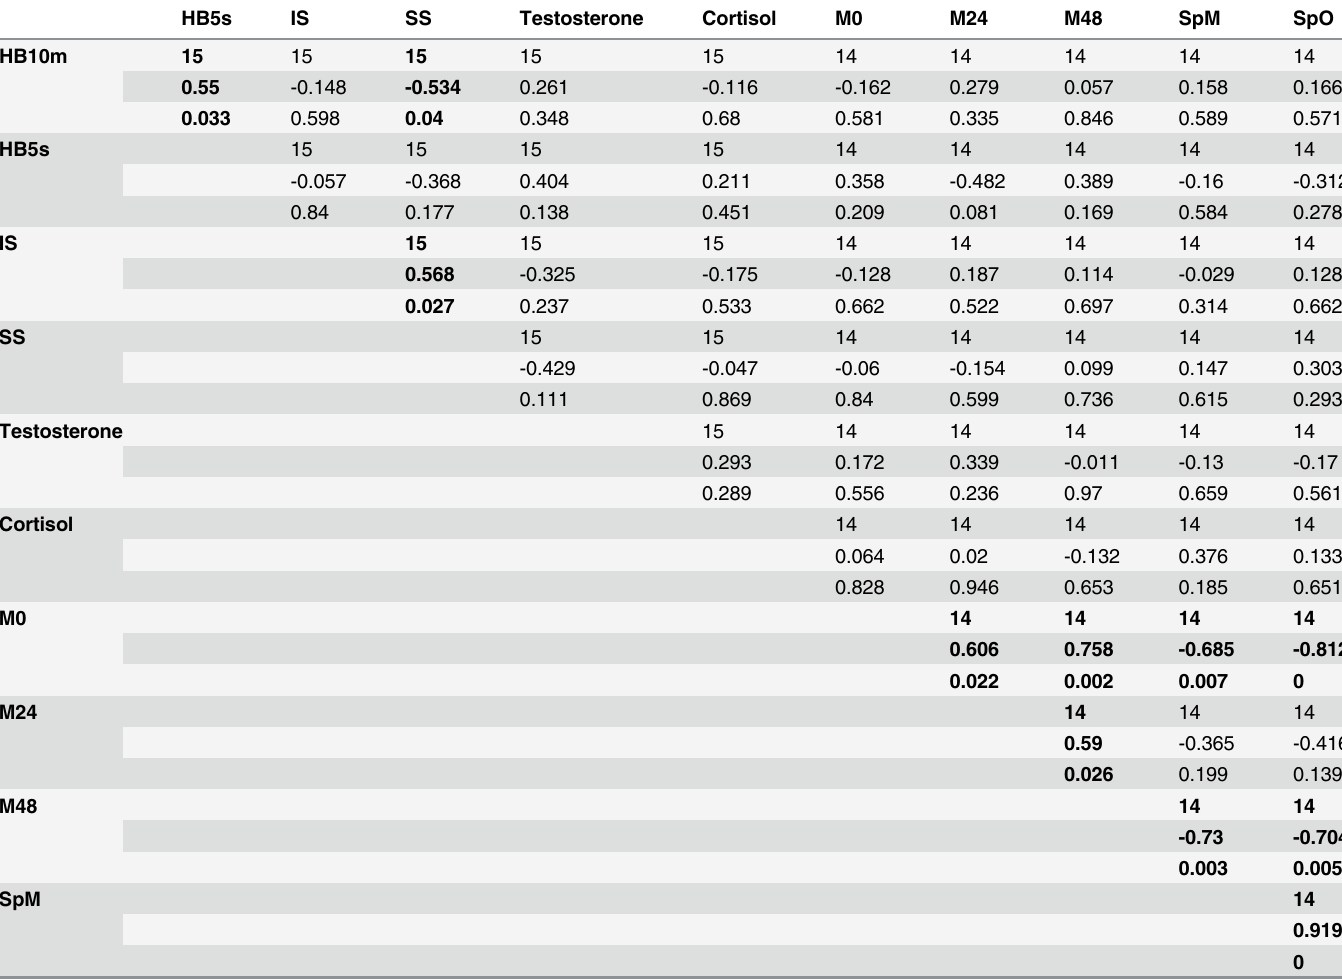
Table 3. Relationships among physiological